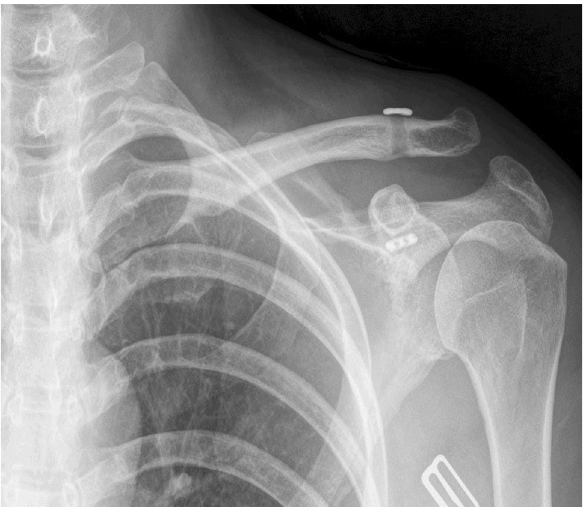
Figure 3. Redislocation was observed 1 day after the MITR